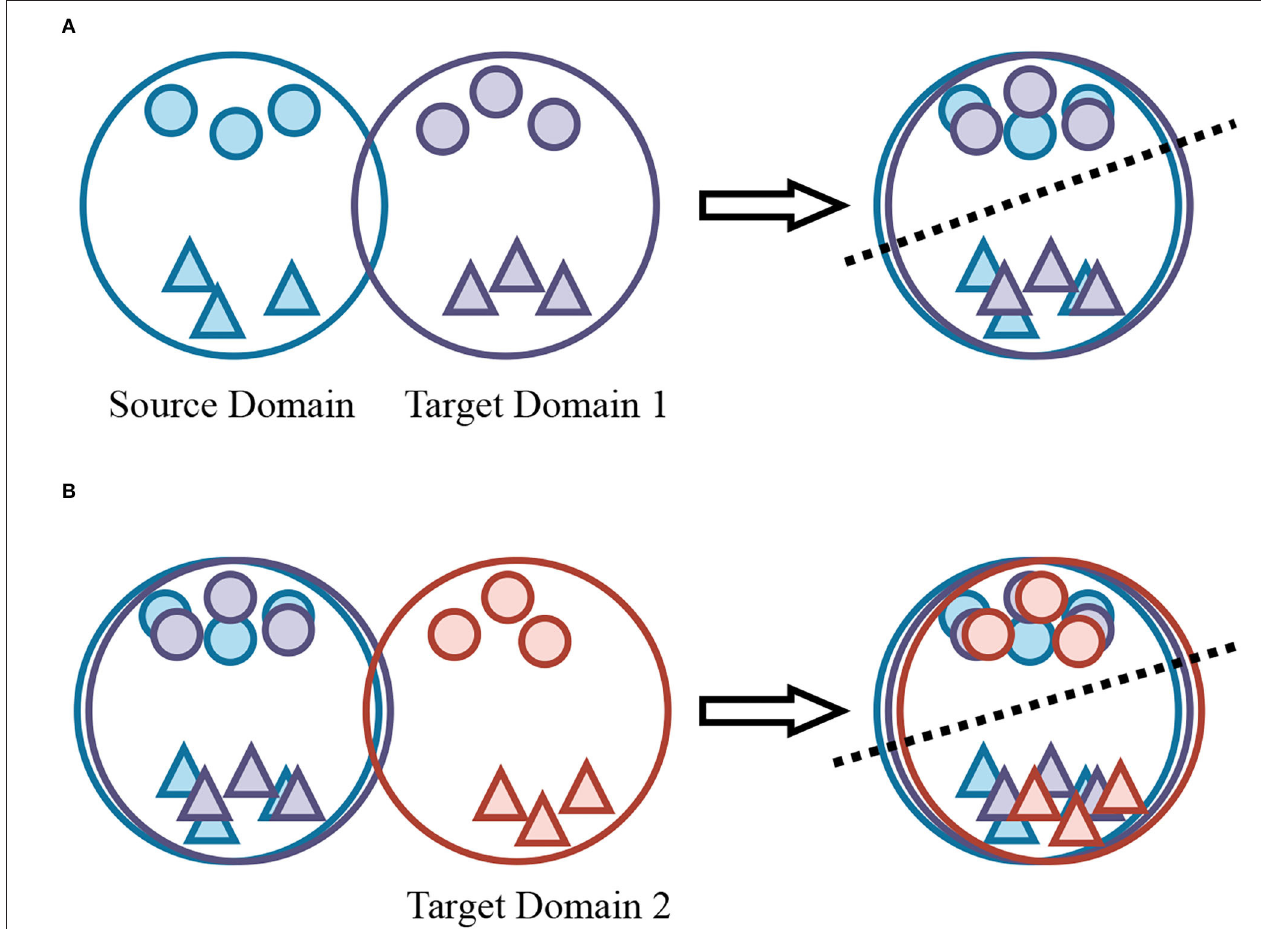
FIGURE 1 | Illustration of the single-step domain adaptation and domain-incremental adaptation. The color blue, purple, and red represents the source domain, the first target domain (A) , and the second target domain (B) , respectively, while different shapes mean different classes in one domain. Single-step domain adaptation consists of pixel-level and instance-level alignment to further minimize the domain gap. For domain-incremental cases, the novel target domain needs to align with all previous